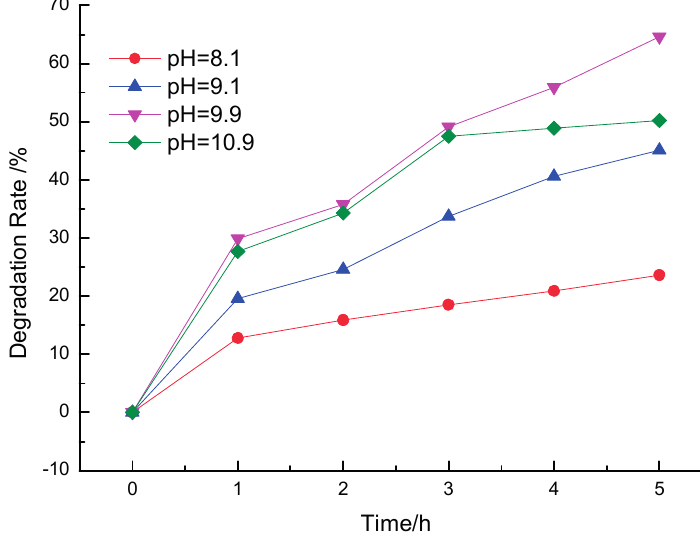
Figure 5. The effect of pH on the degradation of NH 4+ -N with La/Fe/TiO 2